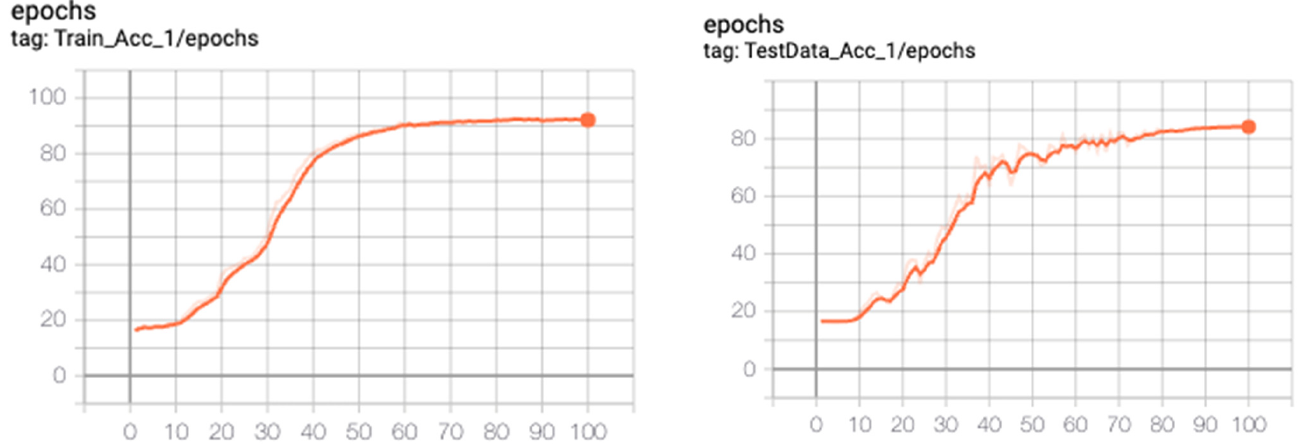
Figure 10. MobileNet neural network training accuracy and loss function change.